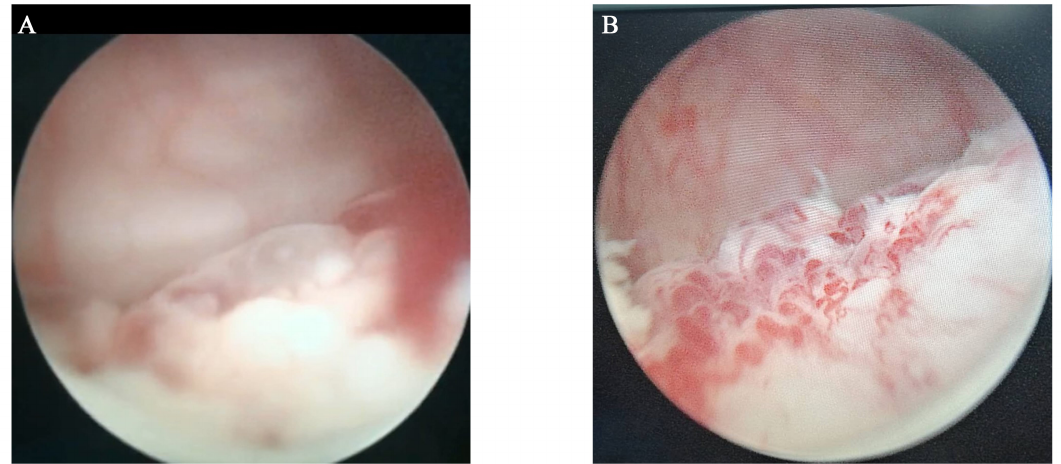
Fig. 3. Transurethral cystoscopy. (A,B) Transurethral cystoscopy showed an extensive cauliflower-like neoformation covering the posterior urethra and prostate with massive tortuous blood vessels attached.